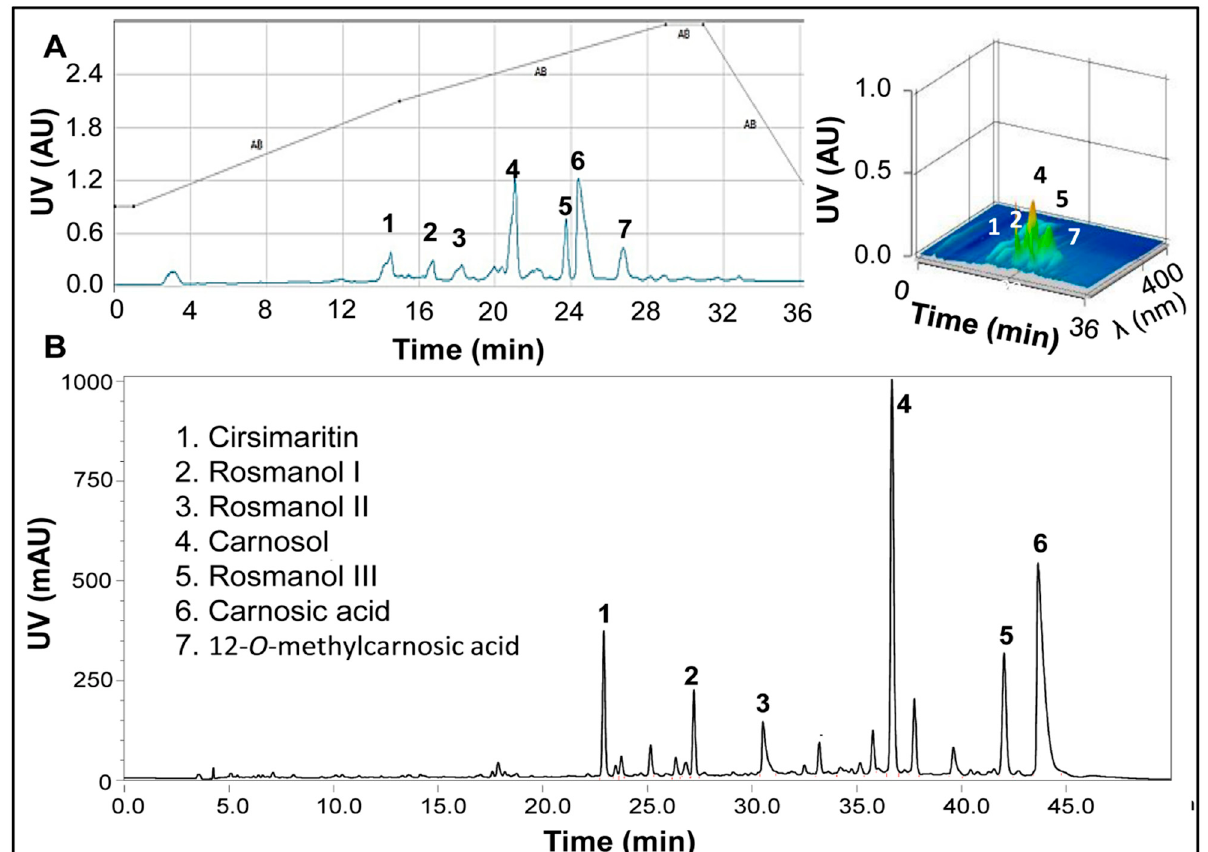
Figure 1. Separation and identification of major compounds in oil-soluble rosemary extract (RE). ( A ) Representative semi-preparative HPLC chromatogram of RE along with the corresponding 3D UV scan. ( B ) Representative analytical HPLC chromatogram of RE. Details of semi-preparative and analytical methods are described in Section 2.2. Peaks were identified by LC–MS/MS.